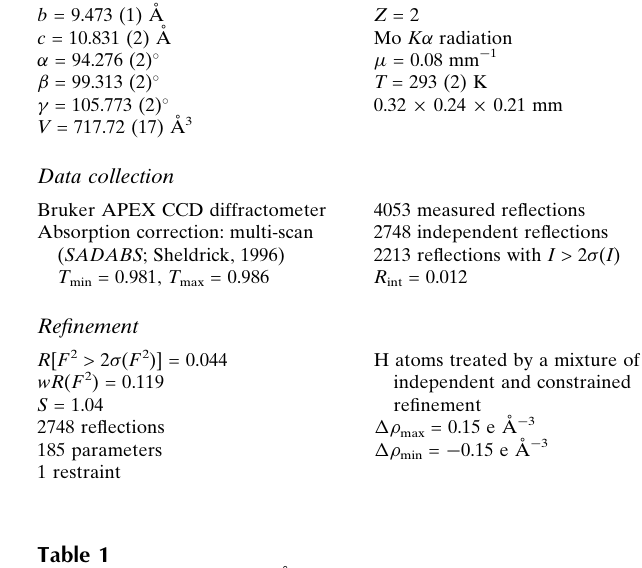
Hydrogen-bond geometry (A˚ , (cid:1)